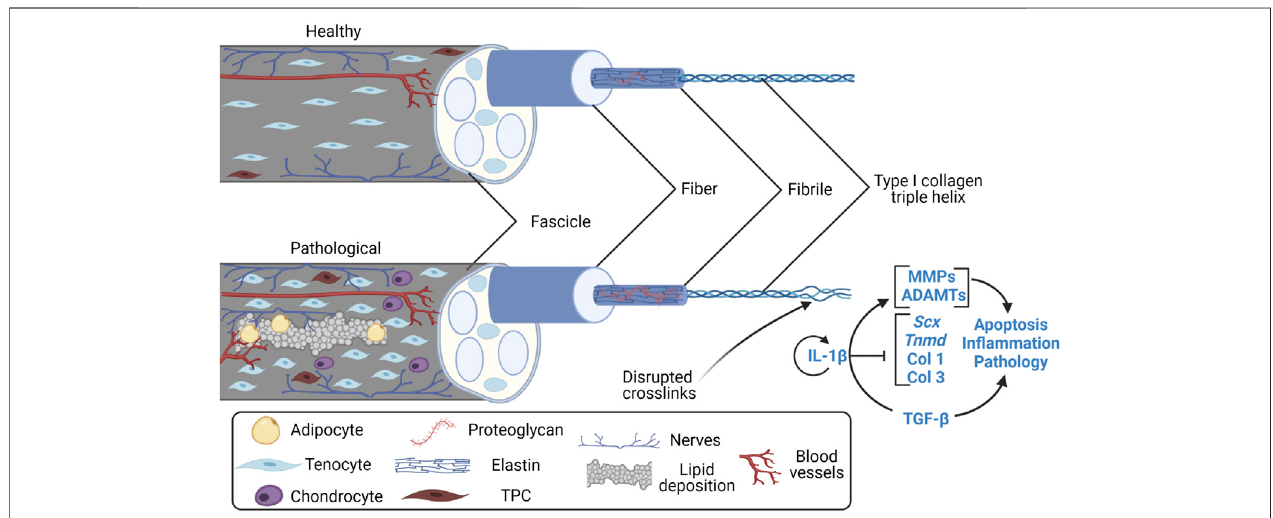
FIGURE 1 | Features of the healthy and pathological tendon fascicle. Created with Biorender.com. Features of the clinically pathological tendon fascicle (a hierarchical subunit of whole tendon) include lipid deposition, angiogenesis, nerve ingrowth, adipocyte and chondrocyte-like TPC differentiation (Kannus and Józsa, 1991; Józsa and Kannus, 1997; Zhang and Wang, 2010, 2014; Agarwal et al., 2017), increases in proteoglycan content (Fu, Chan and Rolf, 2007; Samiric et al., 2009; Attia et al., 2014), collagen type III RNA upregulation/deposition (Liu et al., 1995; Samiric et al., 2009), and irregularities in collagen alignment/crosslinking at previous microscopic to macroscopic rupture sites (Kannus and Józsa, 1991; Józsa and Kannus, 1997; Järvinen et al., 2004). Overall, the pathological tendon is mechanically weaker than the healthy tendon. TPC, tendon progenitor cell; Scx, Scleraxis; Tnmd, Tenomodulin; Col 1, collagen type I; Col 3, collagen type III; MMP, matrix metalloproteinases; ADAMT, disintegrin and metalloproteinase with thrombospondin motifs; IL-1 β , interleukin-1 β ; TGF- β , transforming growth factor β .